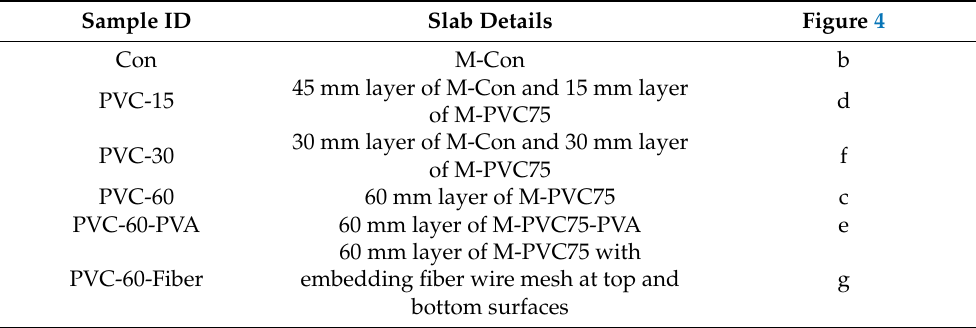
Figure 4. ( a ) Elevation view, ( b ) Con, ( c ) PVC-15, ( d ) PVC-30, ( e ) PVC-60, ( f ) PVC-60-PVA, ( g ) PVC-60-Fiber, ( h ) plan view specimens.